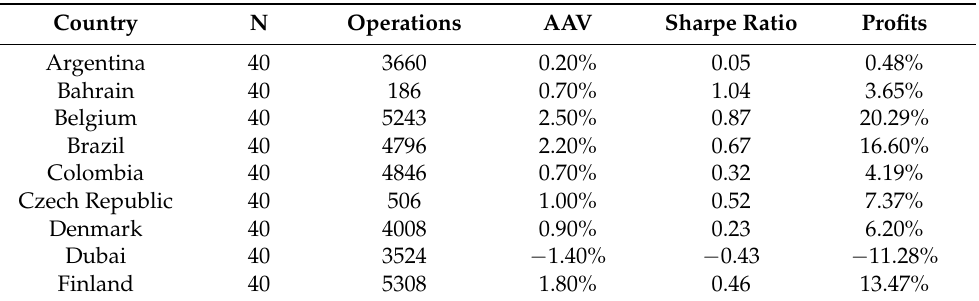
Table A6. Results obtained for the period 2007–2014 (40 Pairs), where N is the number of pairs; AAV Average annualized return; and Profit is the profitability for the full period with transaction